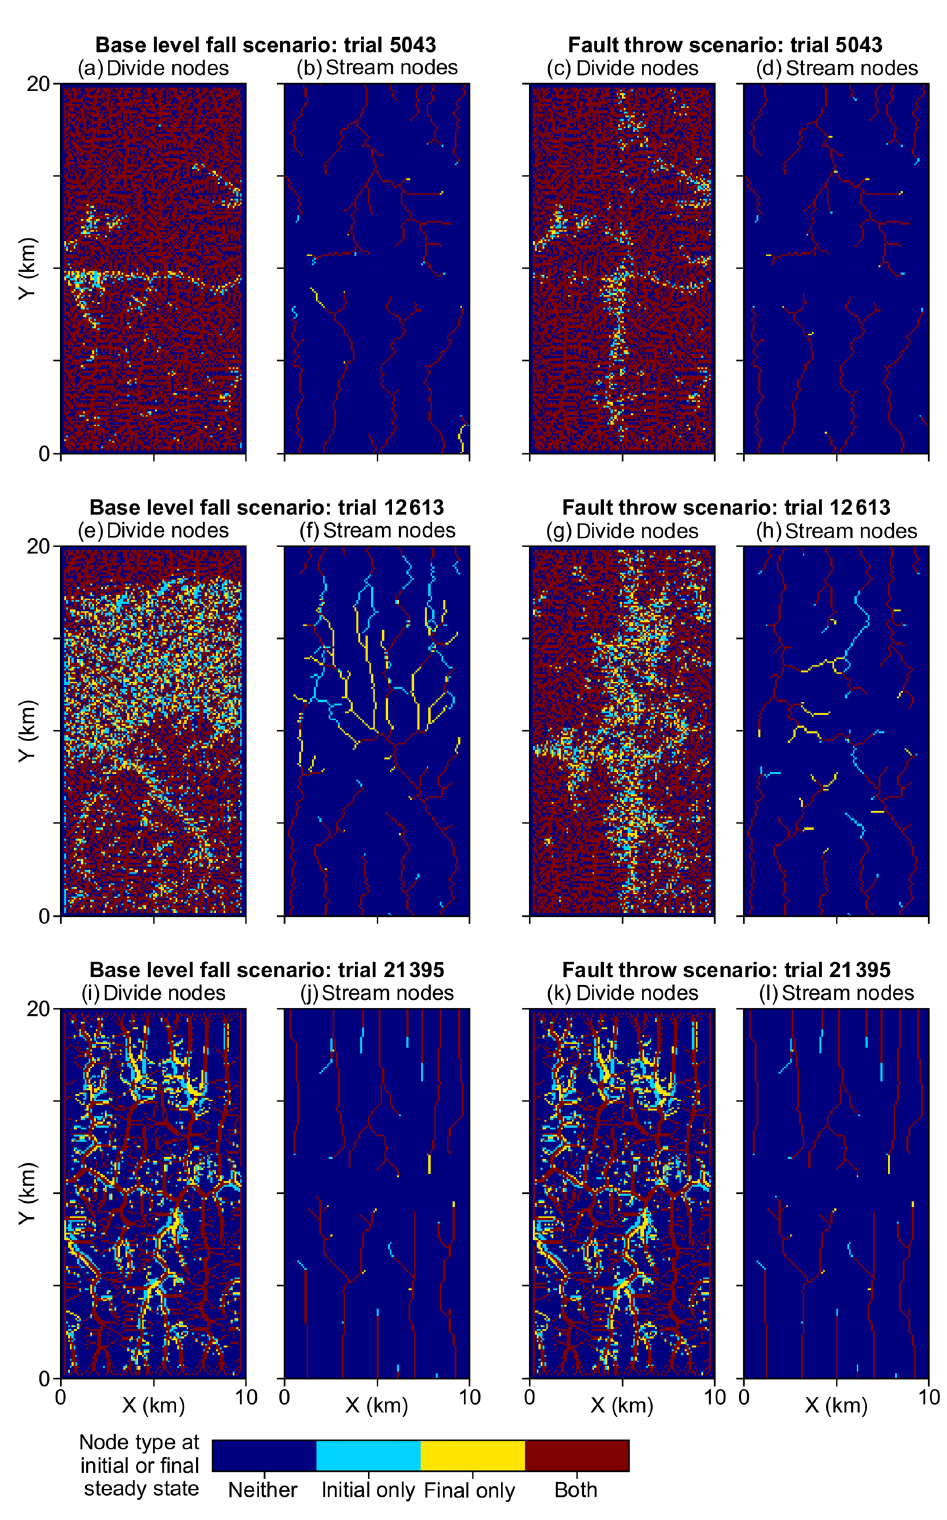
Figure 8. Landform change in exemplary trials. This figure illustrates landform change model responses of the trials discussed in Sect. 4 and labelled in Fig. 7. The colour of grid cells symbolises landform type at the initial and final steady state in the model. Blue areas were not the landform type (divide or stream) in a given subplot at the times of either steady state. Red areas were the subplot landform type in both steady-state times. Cyan and yellow areas were the subplot landform type in the initial and final steady state, respectively. The parameter values of these trials and all other trials are provided in Lyons et al.